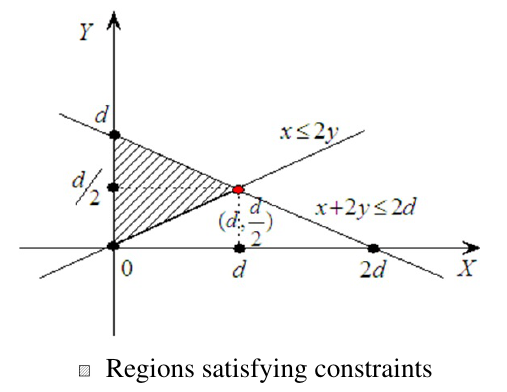
2 , let p ∗ = ( x − d ) . For 2 2 d 2